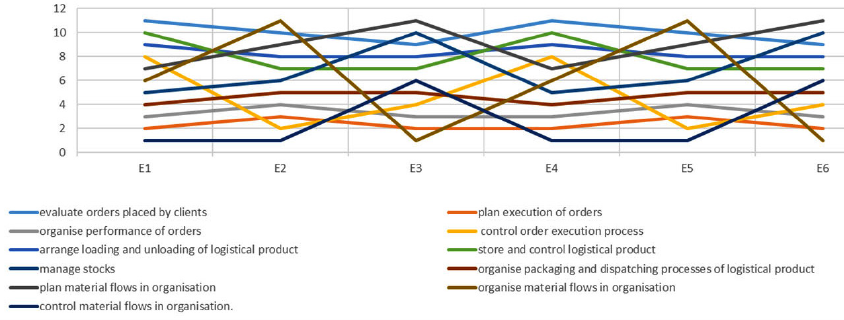
Figure 3. Distribution of expert ranking (compiled by the